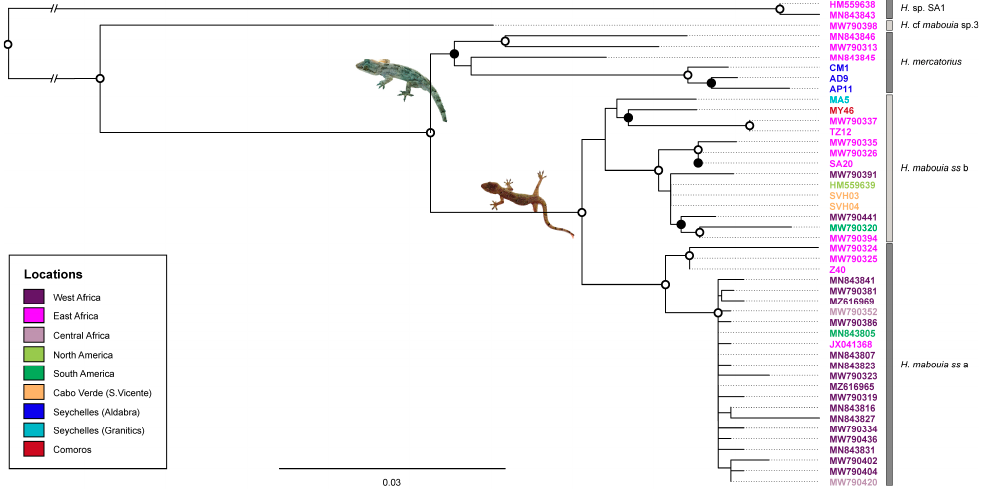
Figure 2. Maximum likelihood (ML) tree for the ND2 fragment showing the relationships between Hemidactylus from Cabo Verde and WIO region and their relatives. Accession numbers are colour coded geographically (for details, see Table S1). The designation of H. mabouia ss a/ b follows a recent study [10]. Bootstrap ( ≥ 70%) and posterior probability (BI) support (>95%) are represented at nodes (solid black dots if there was ML support and open white dots if there was both ML and BI support). The two basal branches were shortened for graphical purposes, and Hemidactylus sp. SA1 was used as an outgroup [10]. See Figure 1 and Table S1 for detailed locality data and GenBank accession numbers of the new sequences.